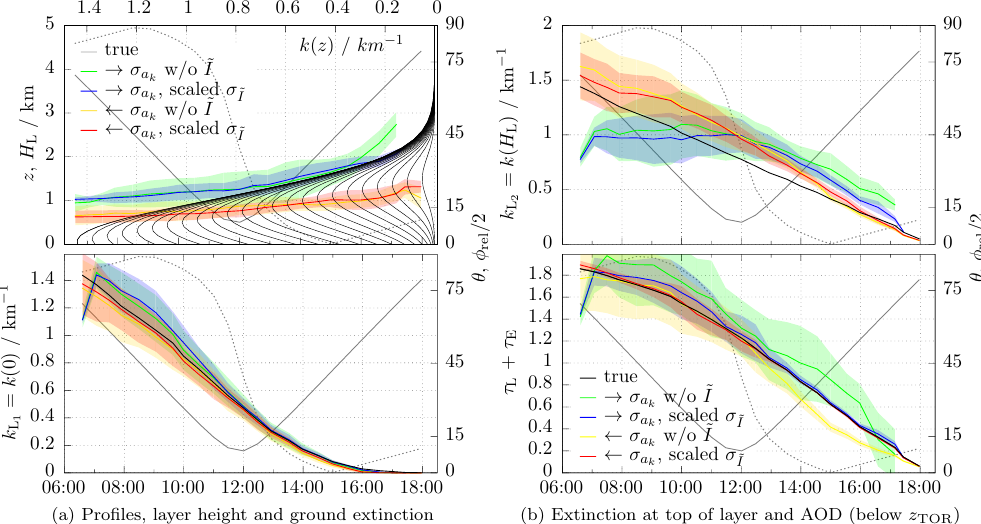
Fig. 18. As Fig. 16, but here with order of profiles reversed in time for retrieval starting with the first ( → ) or last ( ← ) set of DSCDs (and